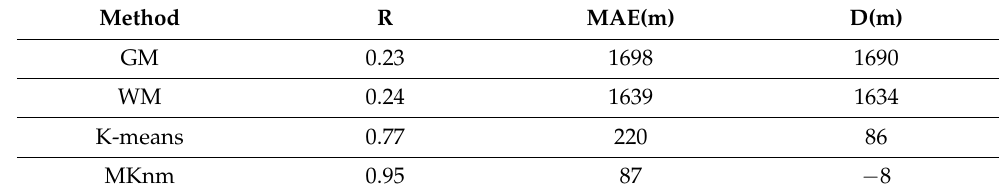
Table 1. Correlation coefficients (R), mean absolute error (MAE), mean deviation (D) between ABLH determined by LiDAR-based methods and